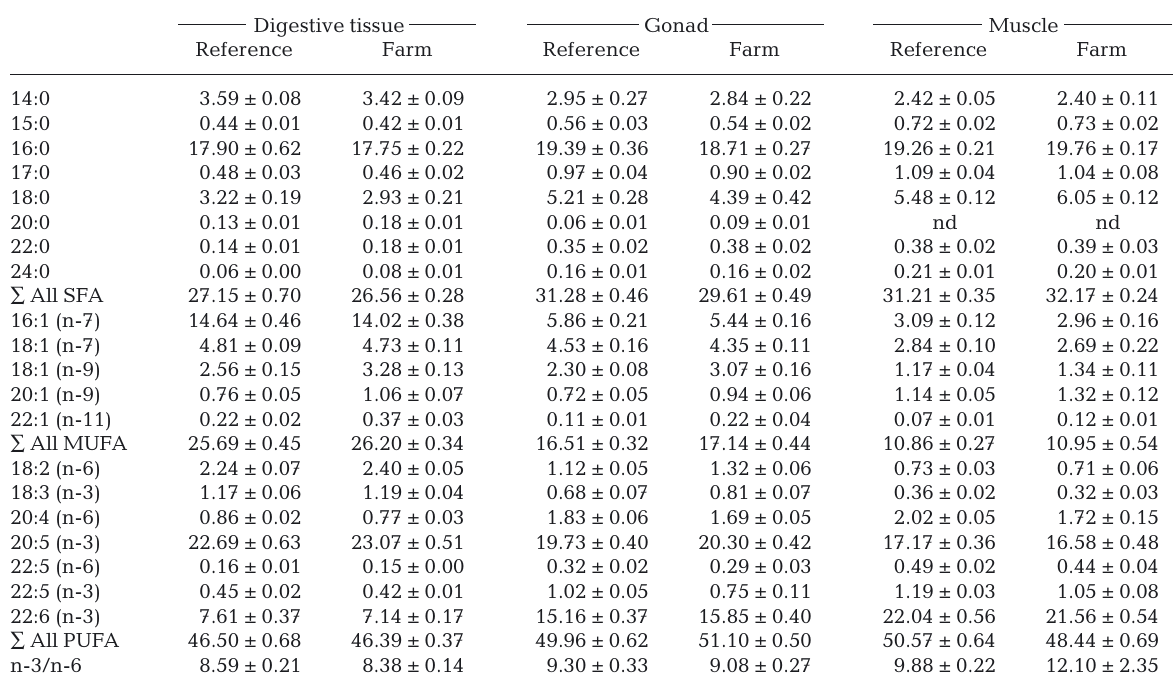
Table A2. Fatty acid profiles of king scallop Pecten maximus tissues (%, mean ± SE). nd: not Digestive tissue